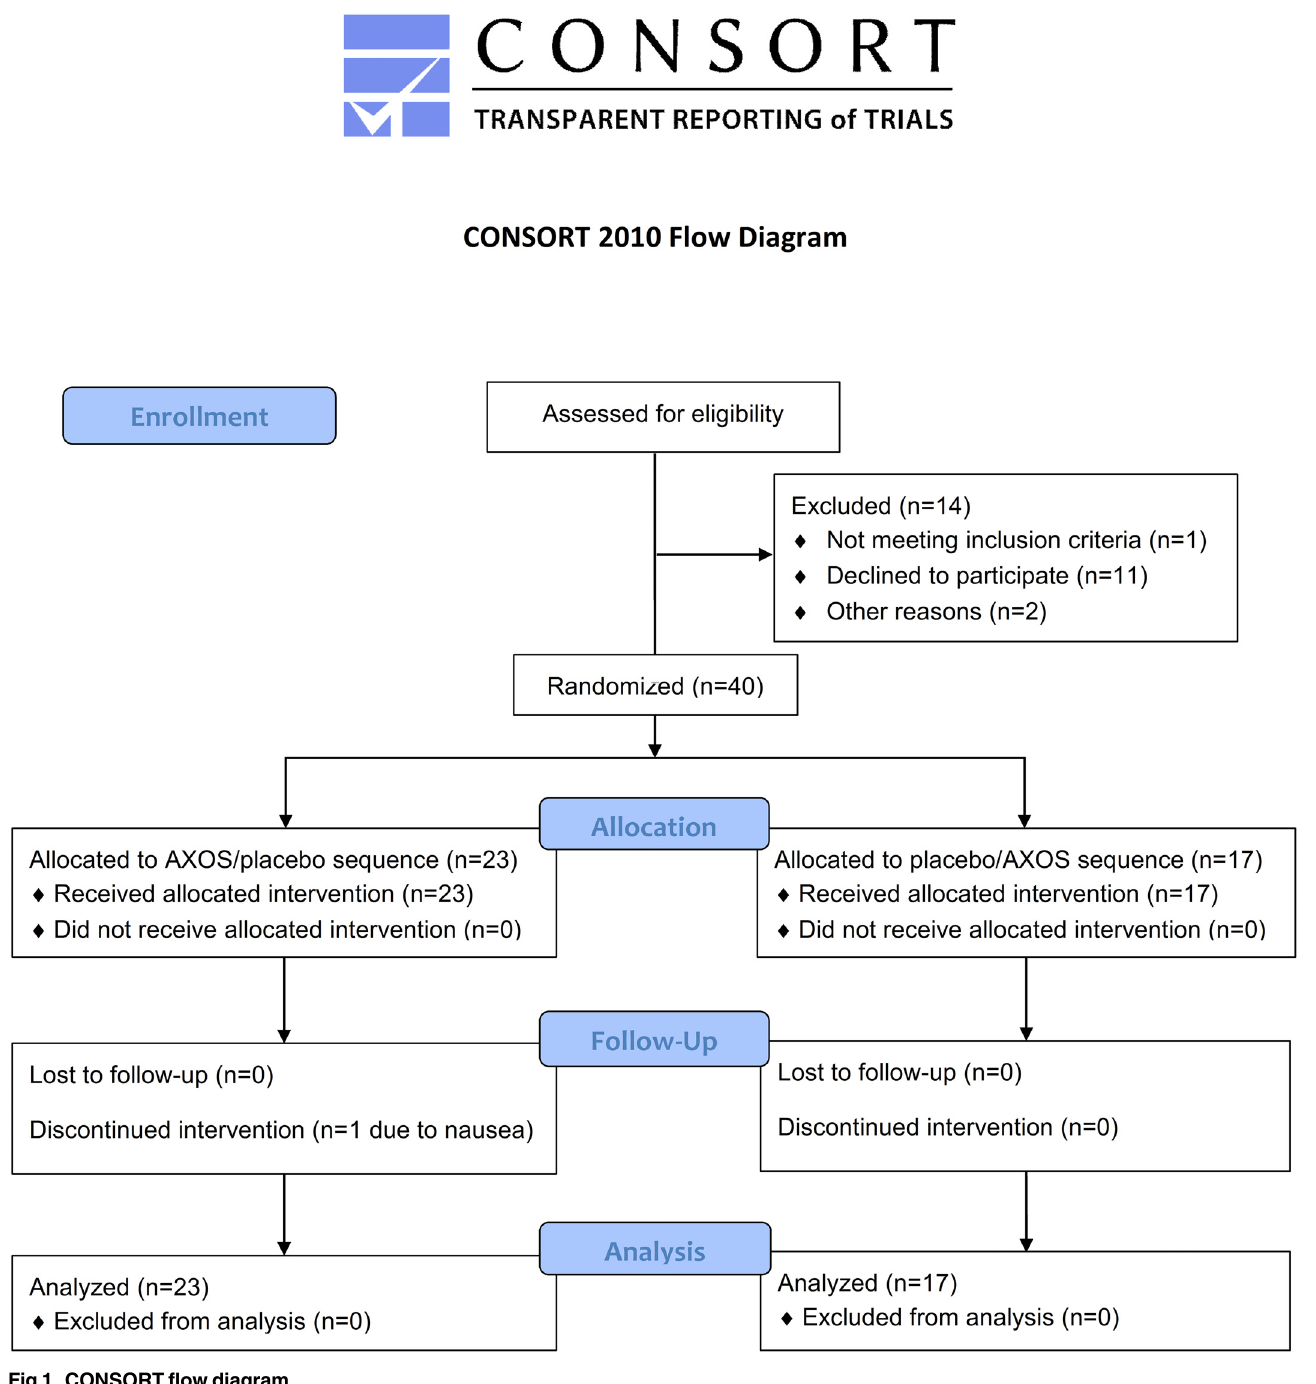
Fig 1. CONSORT flow